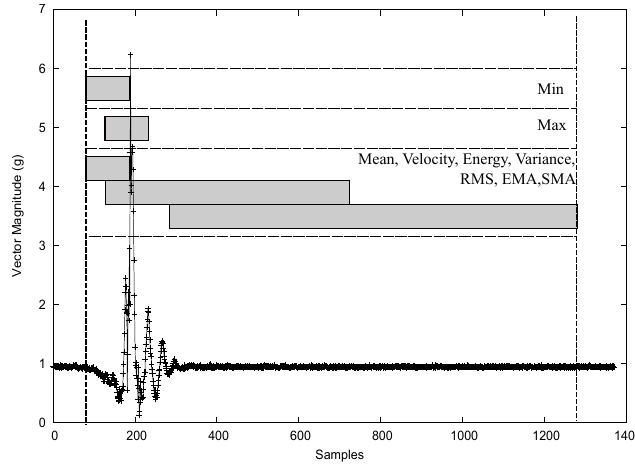
Figure 3: Features window illustration Table 3: Precision, Recall, and f-measure from sliding win- dow based J48 Decision Tree (J48 DT),